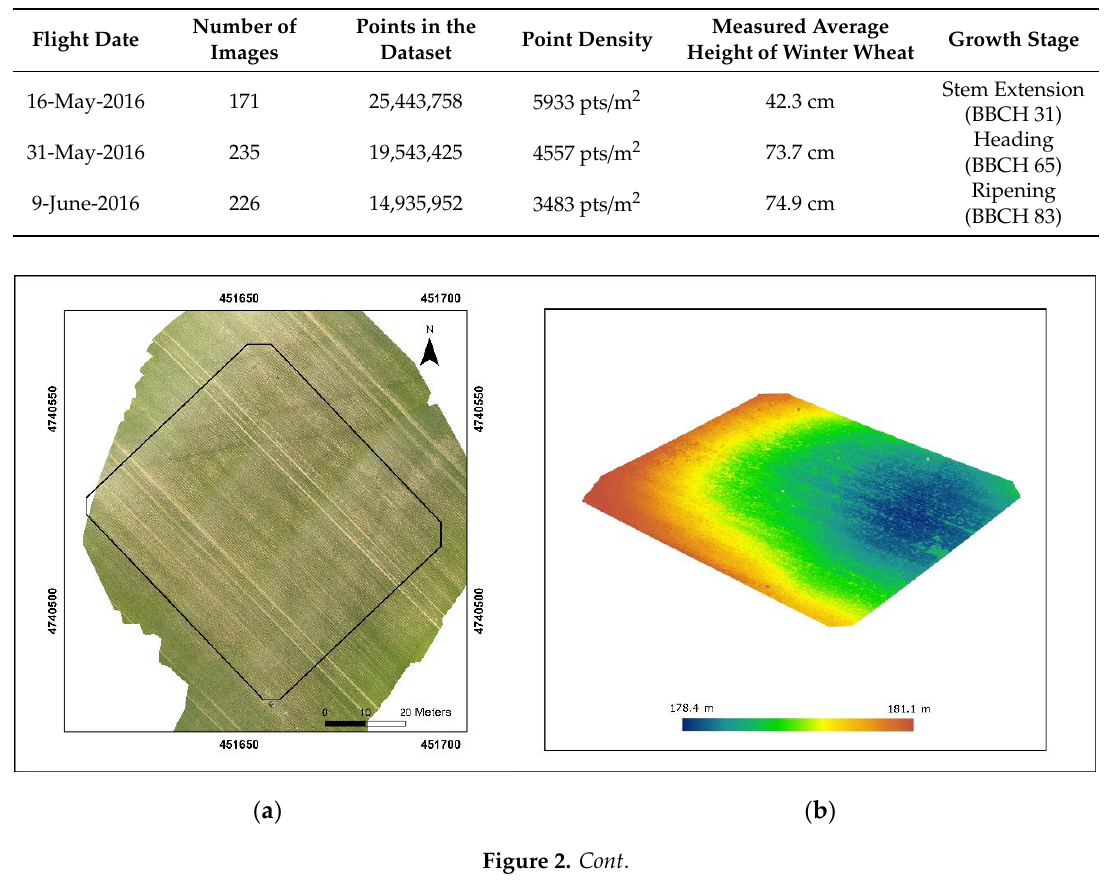
Table 1: Unmanned Aerial Vehicle (UAV) flight dates, number of images, points in the dataset, point density, average ground measurements, and winter wheat growth